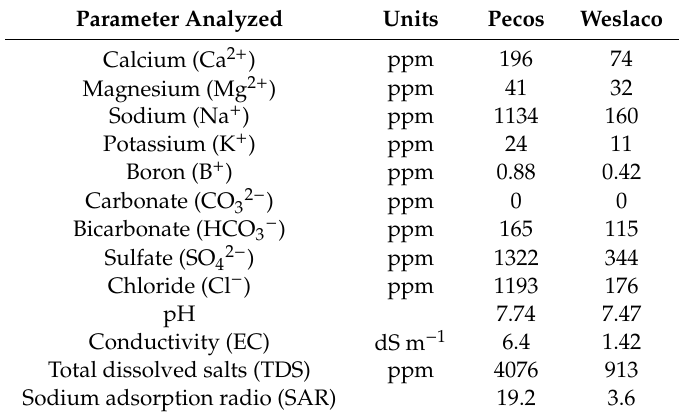
Table 3. Parameters analyzed of the irrigation water quality applied in the di ff erent field